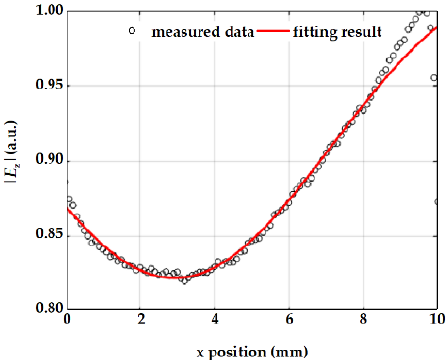
Figure 4. Analytical fitting to the corresponding measured | E z |.